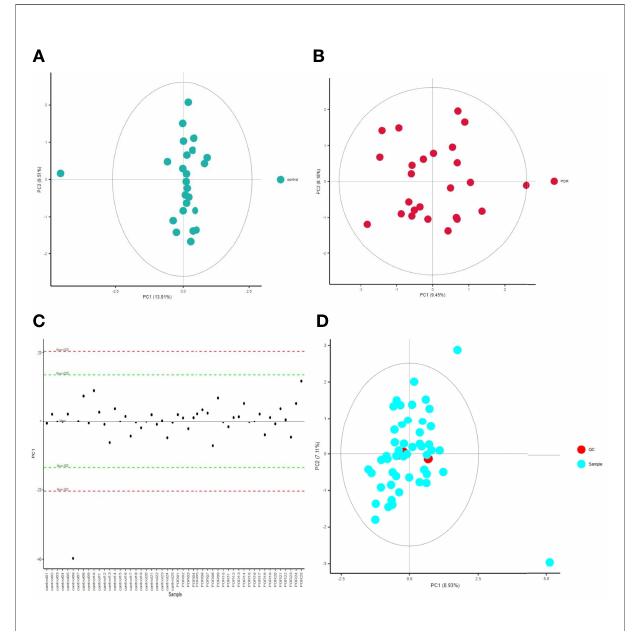
FIGURE 1 | PCA score chart of control group (A) and POR group (B) , and distribution of PC1 in each sample point (C) , PCA chart of QC sample (D) . (C) The abscissa is the test sample, and the ordinate corresponds to the PC1 value of the sample in PCA analysis. (D) The red dot is the corrected quality control sample point (QC sample), and the blue dot is the test